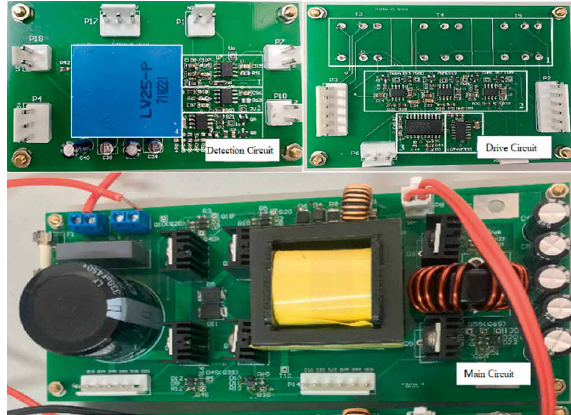
Figure 15: Driving circuit, detection circuit, and main circuit.